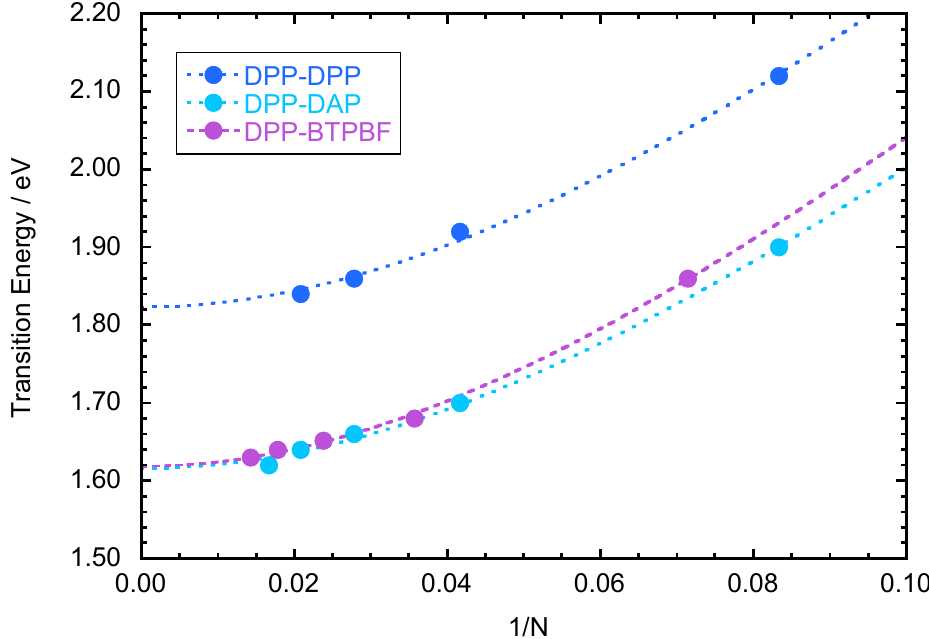
Figure 3. Evolution with chain length of the vertical transition energies of the (A-A’) n oligomers, as calculated at the IEFPCM:M06-2X/6-311G(d) level in chlorobenzene. Lines are fits calculated according to equation 1. Optimized values of the Kuhn fit parameters E 0 and D k are 6.63 eV and − 0.92 for A’ = DPP, 6.10 eV and − 0.93 for A’ = DAP, and 6.39 eV and − 0.94 for A’ = BTPBF.